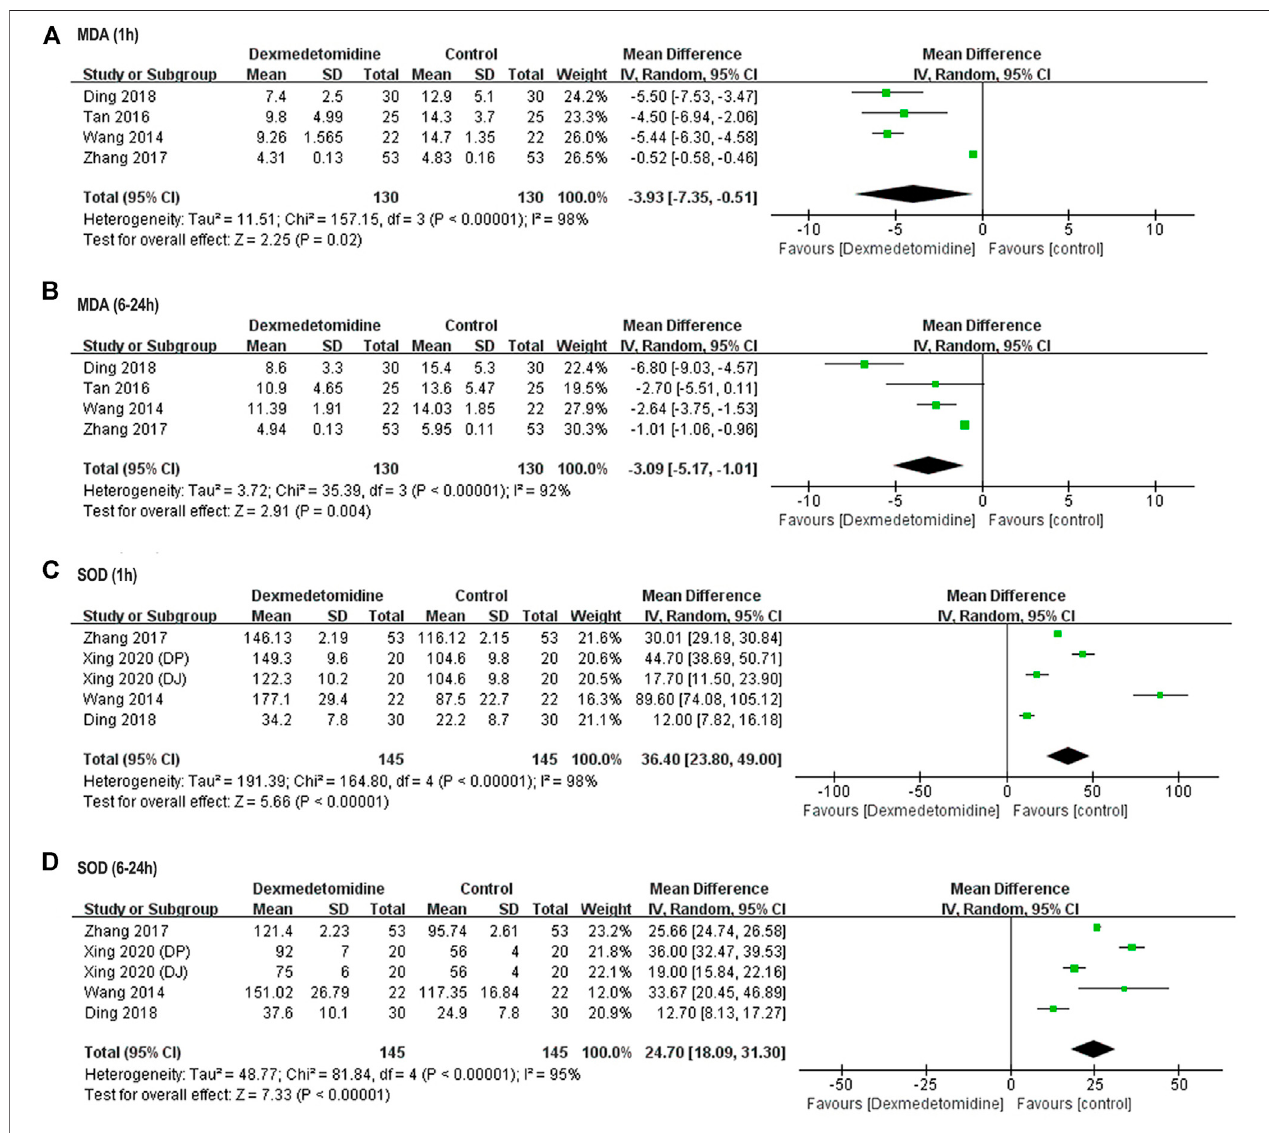
FIGURE 3 | Forest plots for meta-analyses comparing postoperative oxidative stress between dexmedetomidine and control group of participants undergoing hepatectomy. (A) MDA (1 h after surgery); (B) MDA (6 – 24 h after surgery); (C) SOD (1 h after surgery); (D) SOD (6 – 24 h after surgery).